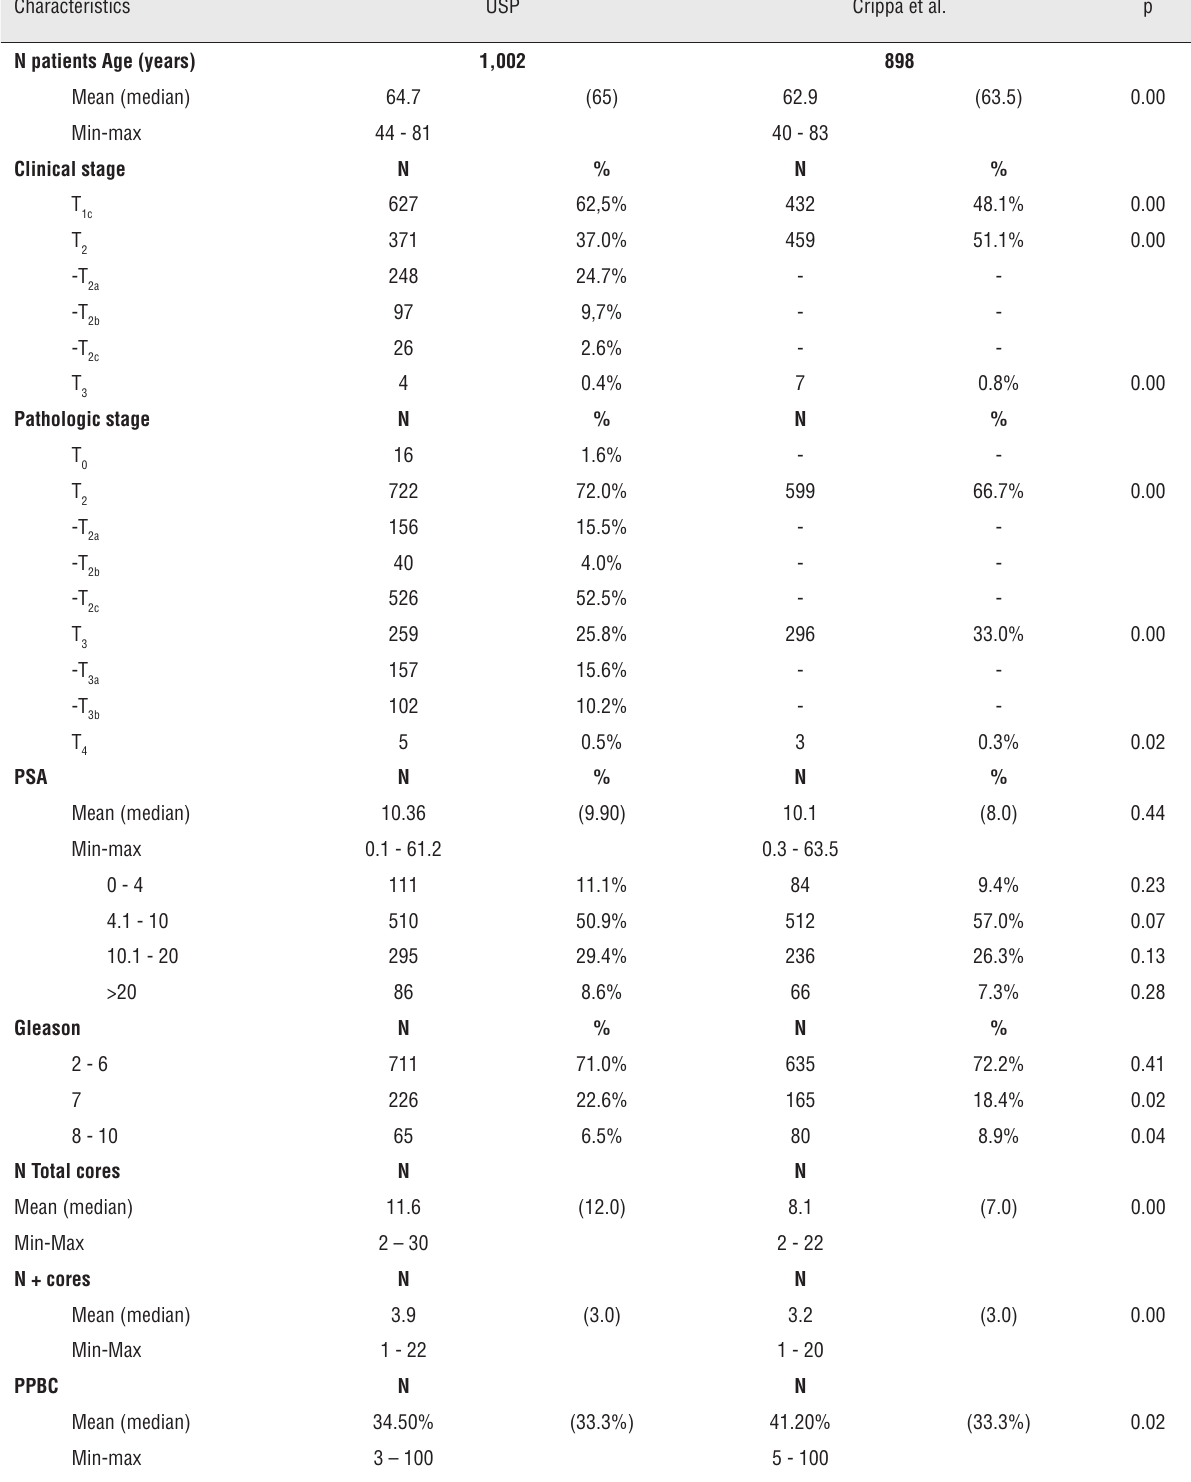
Table 1 – Demographic, clinical and pathological data.